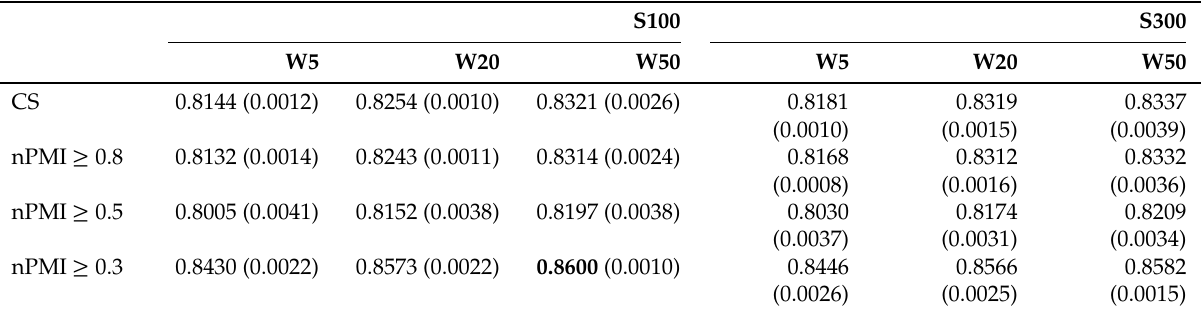
Table 4: Knowledge-based WSD accuracies (standard deviations) using CUI association values (MeSH term co- occurrences), CUI definitions (UMLS), and word embeddings.